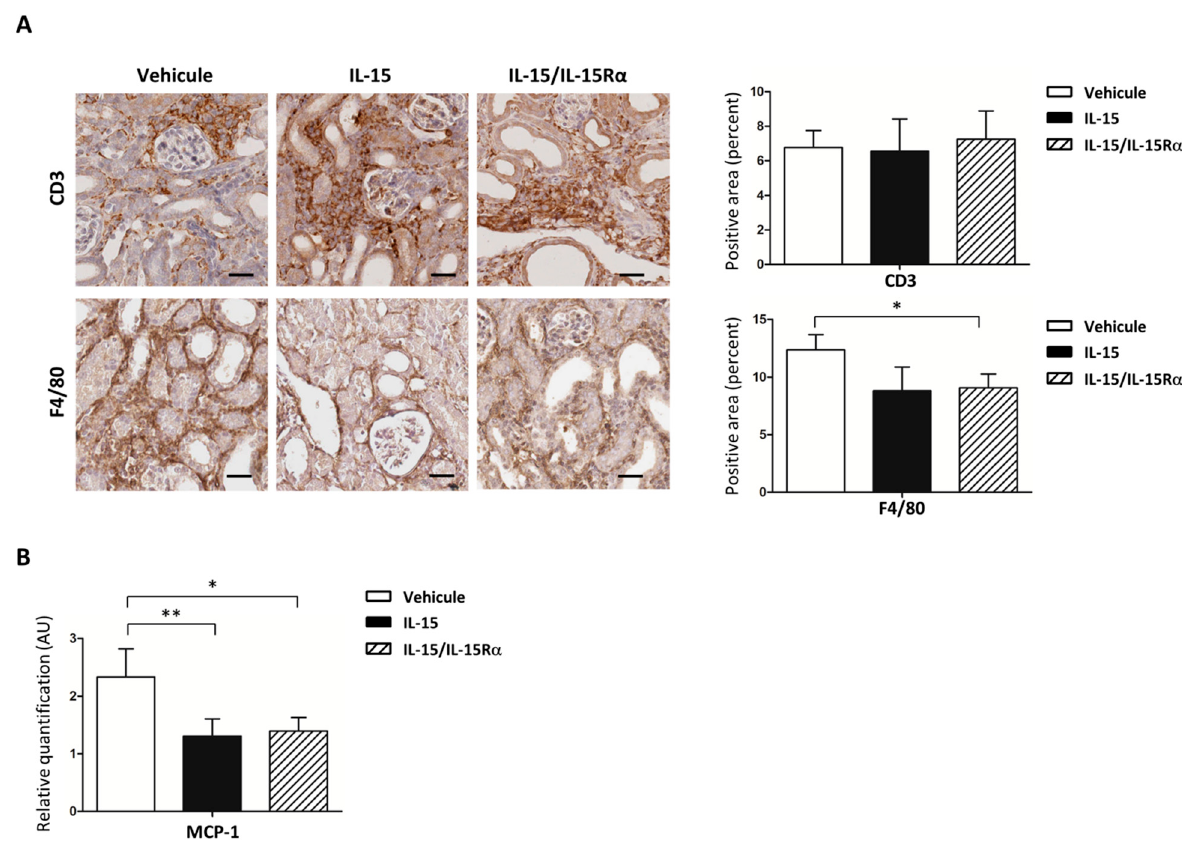
Figure 7. IL-15 decreases both macrophage infiltration and MCP-1 expression in 8 d-post obstructed kidneys. ( A ) Immunohistochemistry of CD3 and F4/80 positive cells in 8 d-post obstructed kidney cortex. CD3 lymphocyte infiltration in the kidney cortex was not modified by IL-15 (solid bars) and IL-15/IL-15R α (hatched bars) treatments. On the other hand, both IL-15 treatments showed reduced infiltration of macrophages (F4/80+) during UUO. Left, Representative IHC staining of one experiment are shown. Scale bars, 25 µm. Right, Bar charts represent morphometric quantification. * p < 0.05 comparing vehicle (Veh, open bars) vs. IL-15/IL-15R α (hatched bars)-treated mice, n = 7 per group. ( B ) RT-qPCR analysis of MCP-1 mRNA in kidney cortex normalized to Gus B mRNA. AU, arbitrary units. Values are means ± SEM from seven mice by group. ** p < 0.01 and * p < 0.05 comparing IL-15- or IL-15/IL-15R α -treated mice to vehicle-treated mice.